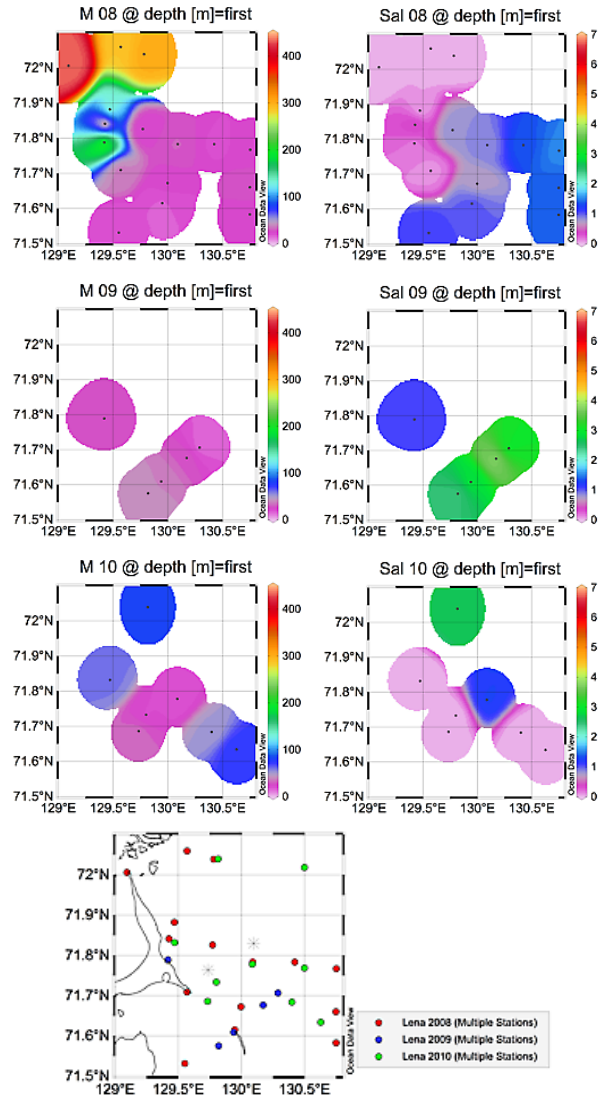
Fig. 4. Surface methane concentrations and salinities in the estu- ary for the years 2008, 2009 and 2010, within a “common area” as shown in the map inlet.